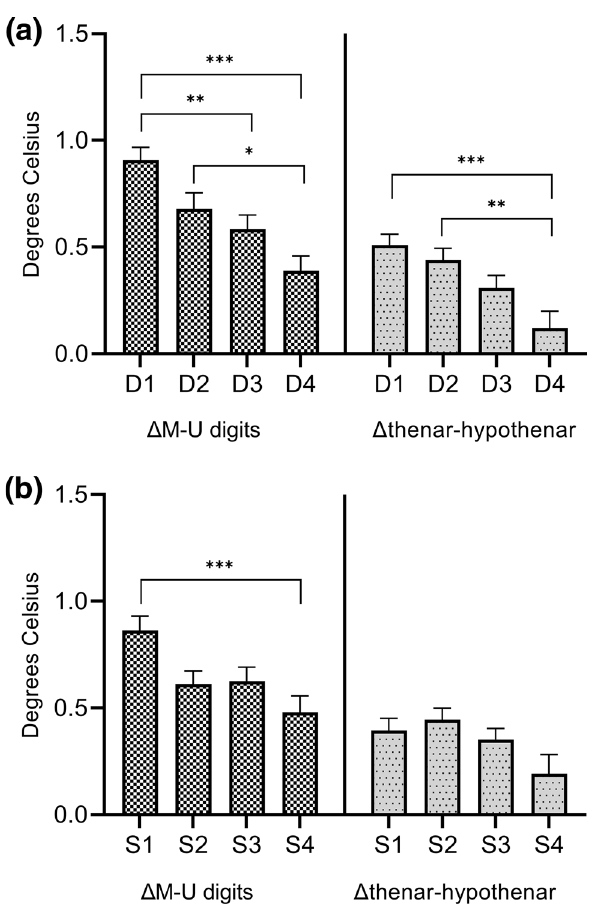
Figure 4. Comparisons of the temperature differences between the median and ulnar nerve digits (ΔM-U digits) and temperature differences between the thenar and hypothenar areas (Δthenar-hypothenar) according to duration ( a ) and severity ( b ). Significant differences in ΔM-U digits between the D1 and D3, D1 and D4, D2 and D4, and S1 and S4 groups are observed. Significant differences in Δthenar-hypothenar between the D1 and D4 groups and between the D2 and D4 groups are also observed. This graph is drawn using GraphPad Prism version 9.1.2 for Windows (GraphPad Software, San Diego, California USA, www. graph pad. com). D, duration group; S, severity group. * P < 0.05. ** P < 0.01. *** P <